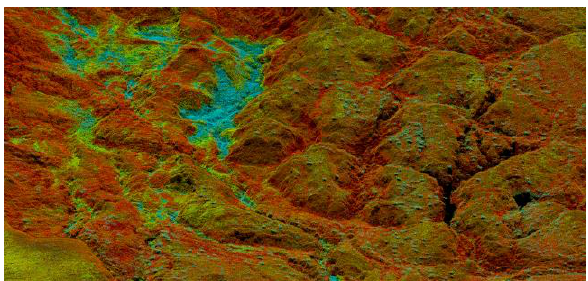
Figure 7. Detail of the irregular 2 cm point distance elevation data computed from the VUX-1HA data. Data portrays the rugged base of the smaller thaw slump. Image width 48 m, elevation difference within the area illustrated is ca. 13 m. Point colours represent point